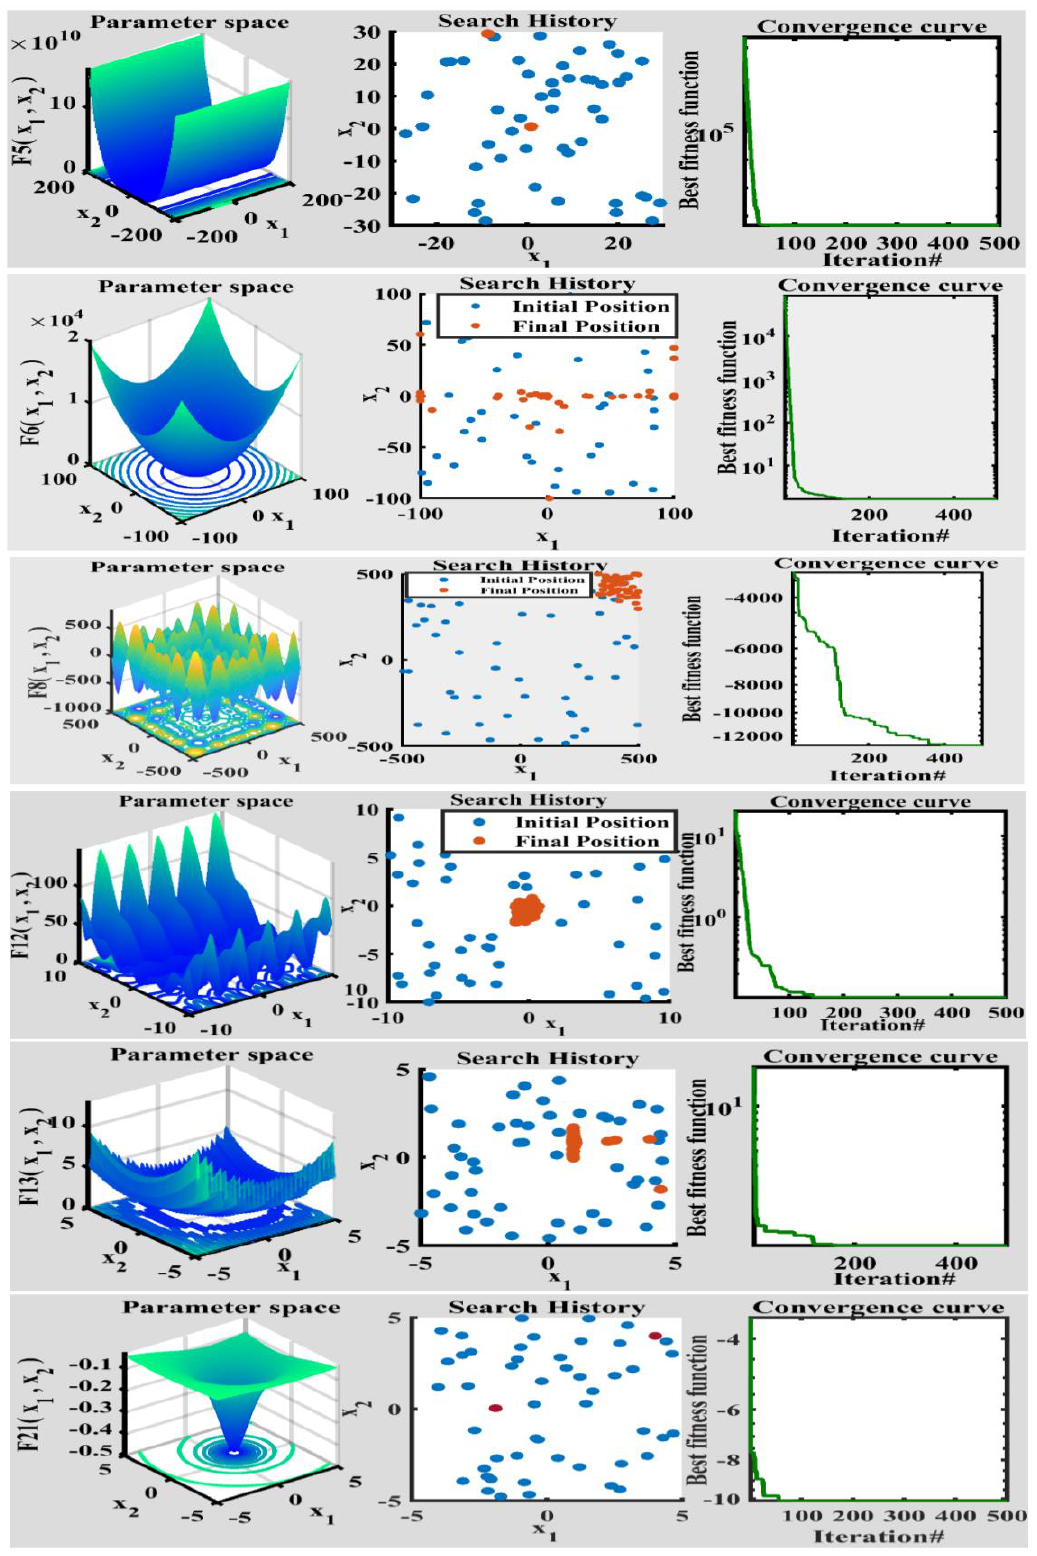
Figure 3. Qualitative results for unimodal, multimodal, and fixed-dimension functions.